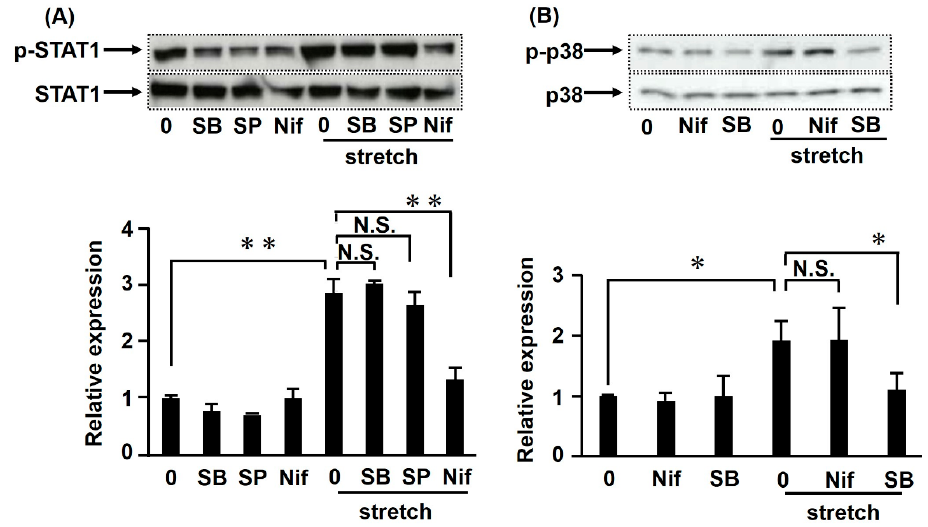
Figure 7. Effects of p38 and STAT1 inhibitors on STAT1 and p38 phosphorylation induced by CMS in RASMCs. RASMCs were pretreated with SB203580 (SB, 20 μ M, 20 min), SP600125 (SP, 20 μ M, 20 min), or nifuroxazide (Nif, 2 μ M, 1 h) and then subjected to CMS for 4 h. Cell lysates were analyzed by immunoblotting using anti-phosphorylated and total STAT1 antibodies ( A ) and anti-phosphorylated and total p38 antibodies ( B ). Phosphorylated STAT1 or p38 levels are expressed as a percentage of the control, normalized to total STAT1 or p38, respectively. The uncropped pictures of immunoblotting are shown in Figure S2. Data are presented as the mean ± SD ( n = 3); * p < 0.05 and ** p < 0.01 versus the CMS control; N.S. indicates no significant difference.